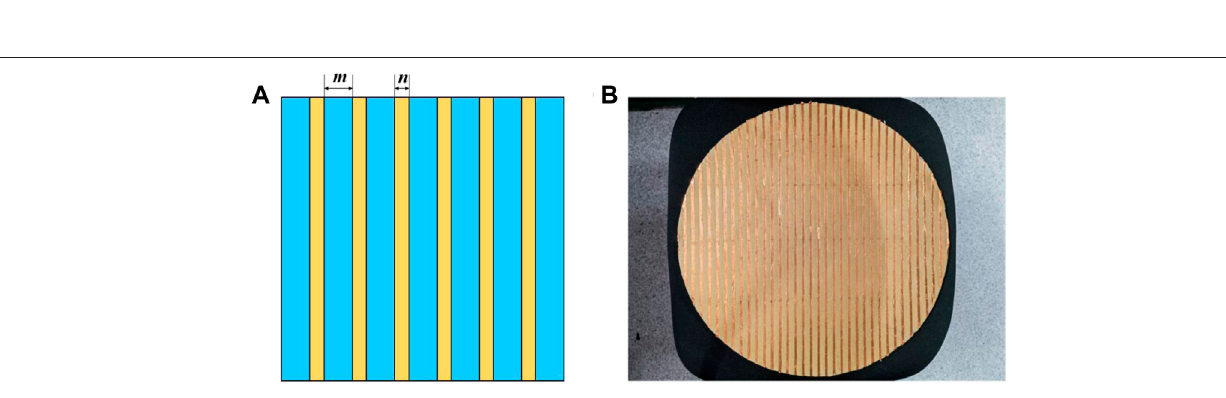
Frontiers in Materials |